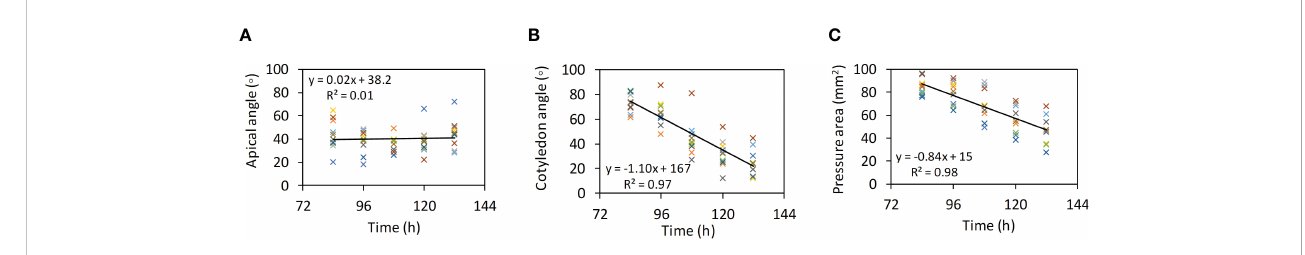
FIGURE 7 Morphological the characteristics of seedlings over time (Test Nos. 1 to 10). (A) Apical angles. (B) Cotyledon angles. (C) Pressure area.